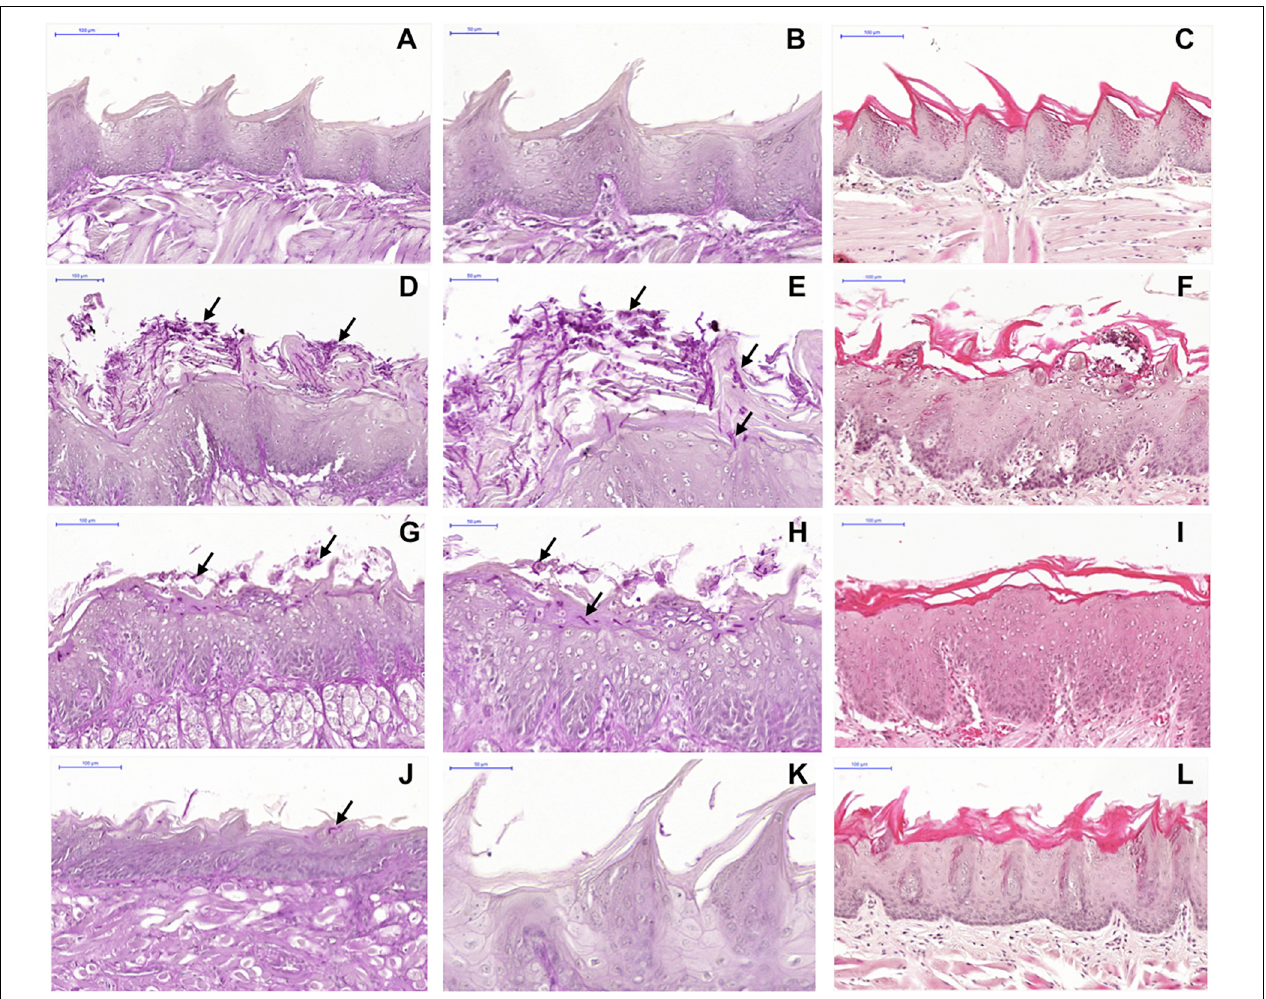
FIGURE 8 | Microscopic images of the dorsum tongue. Control group not infected by C. albicans stained by PAS (A,B) and H&E (C) : normal histological aspect of tongue. Control group infected by C. albicans and not treated stained by PAS (D,E) and H&E (F) : presence of several yeast and hyphae ( → ) in the keratin layer; epithelial changes with microabscesses, exocytosis, spongiosis and loss of filiform papillae; and formation of inflammatory infiltrate in lamina propria. Groups treated with SM-F1 stained by PAS (G,H) and H&E (I) or with SM-F2 stained by PAS (J,K) and H&E (L) : reduction in candidiasis lesions in relation to the not treated control